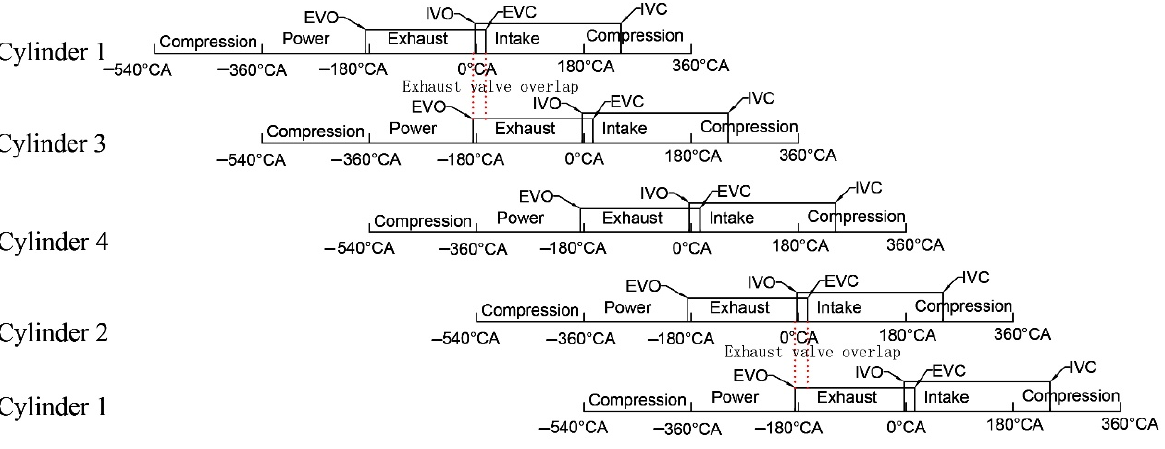
Figure 5. Correspondence between strokes of four cylinders.